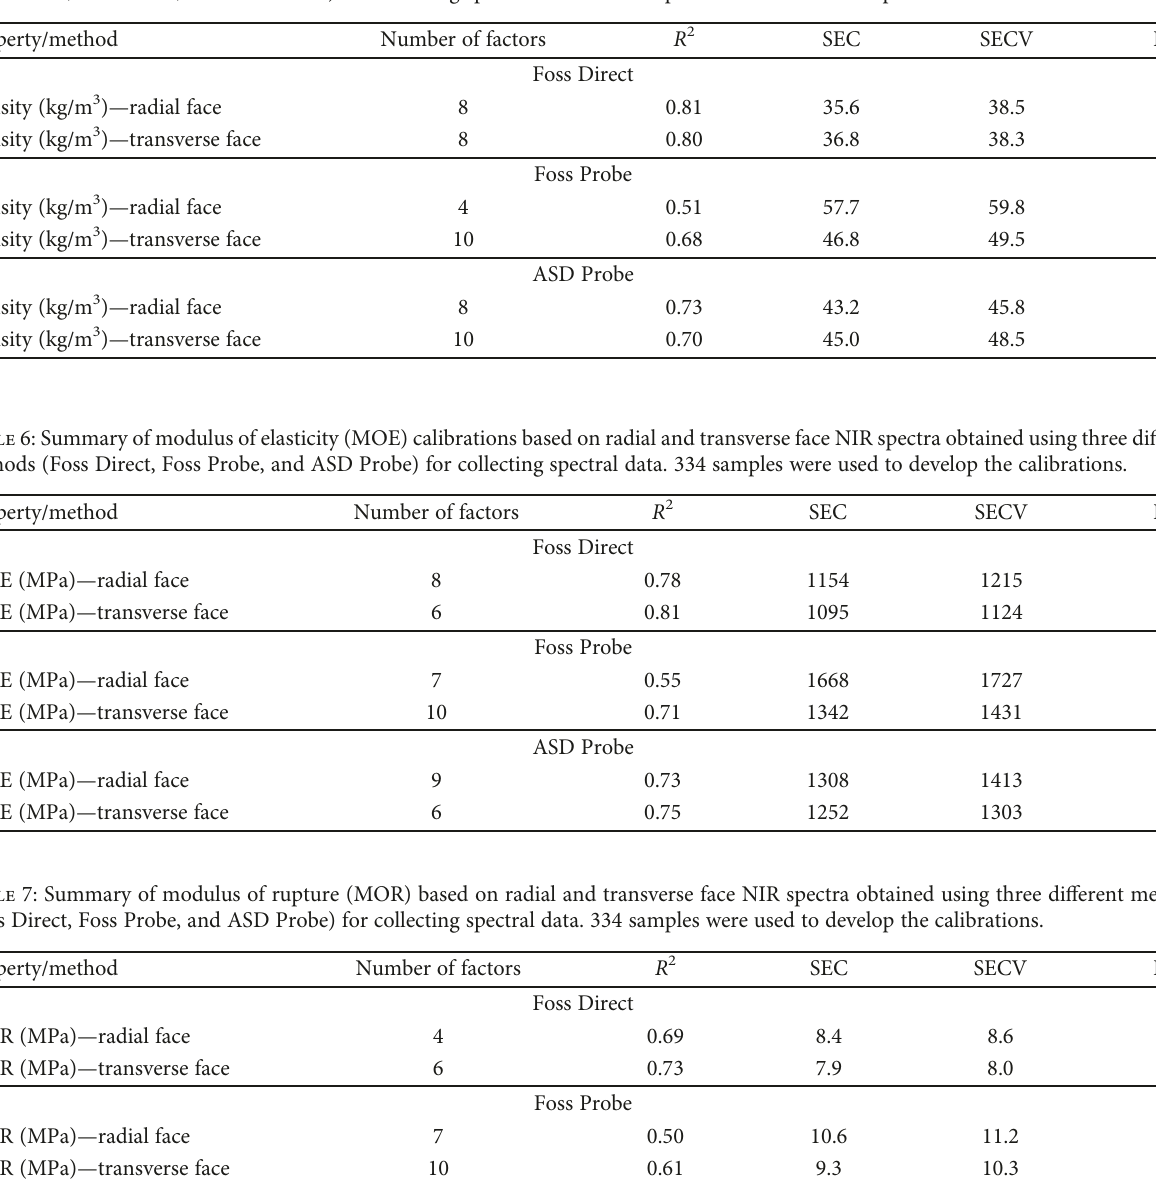
Table 5: Summary of air-dry density calibrations based on radial and transverse face NIR spectra obtained using three di ff erent methods (Foss Direct, Foss Probe, and ASD Probe) for collecting spectral data. 332 samples were used to develop the calibrations.